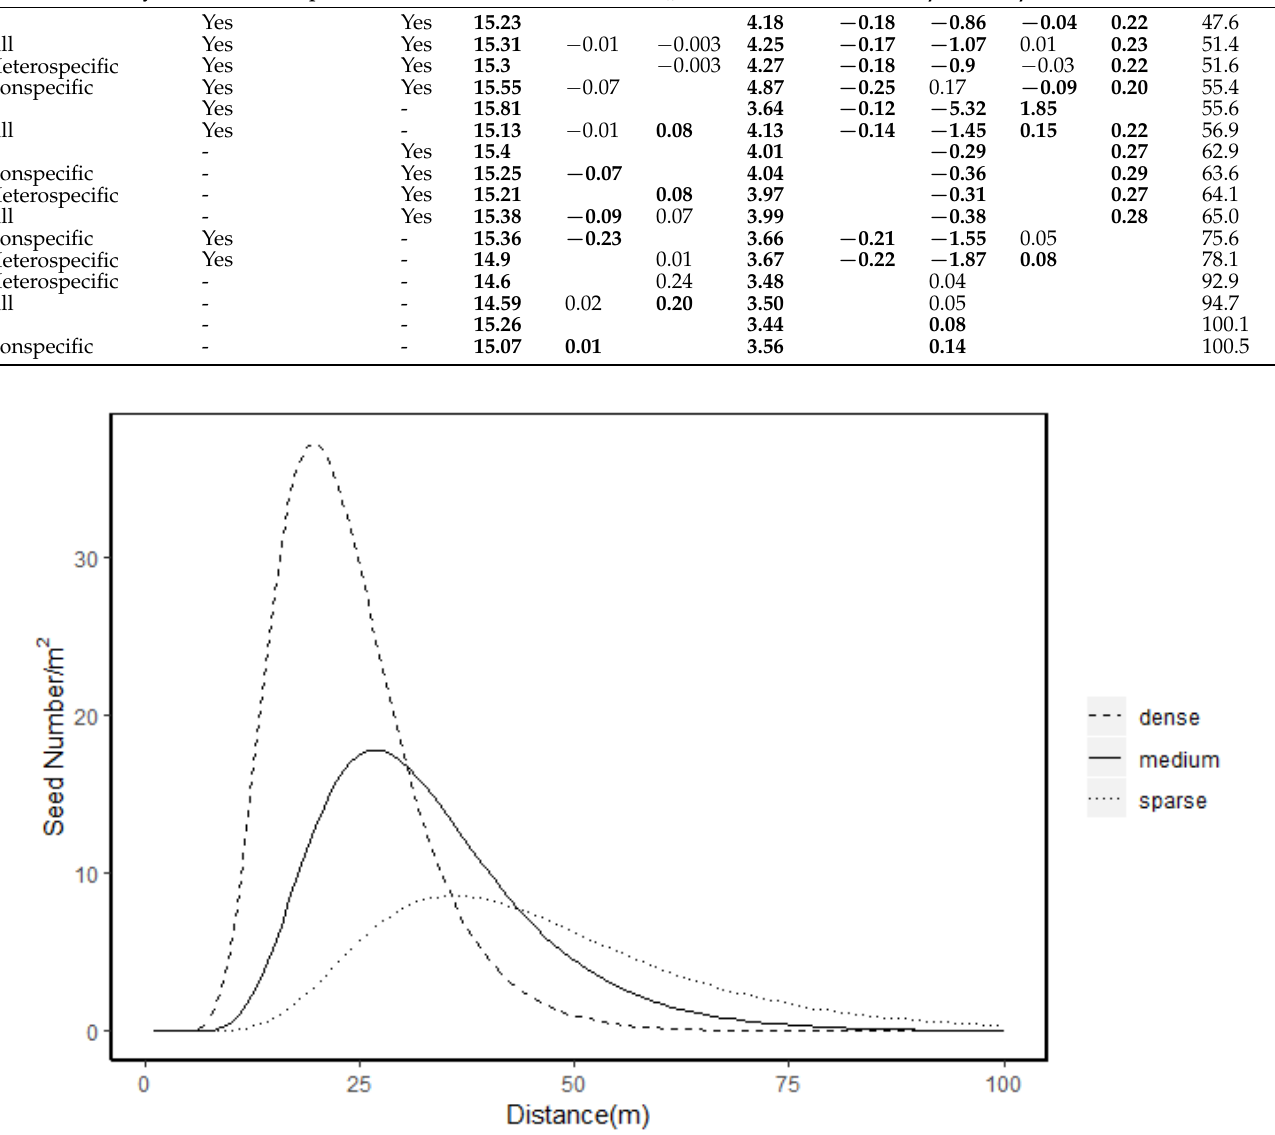
Figure 2. Dispersal kernels of a birch tree producing 10,000 seeds based on parameters of the best model in different environments. The different curves denote dense (0.05 trees/m 2 ), medium (0.03 trees/m 2 ) and sparse (0.01 trees/m 2 ) neighbouring environment where the source tree is located.